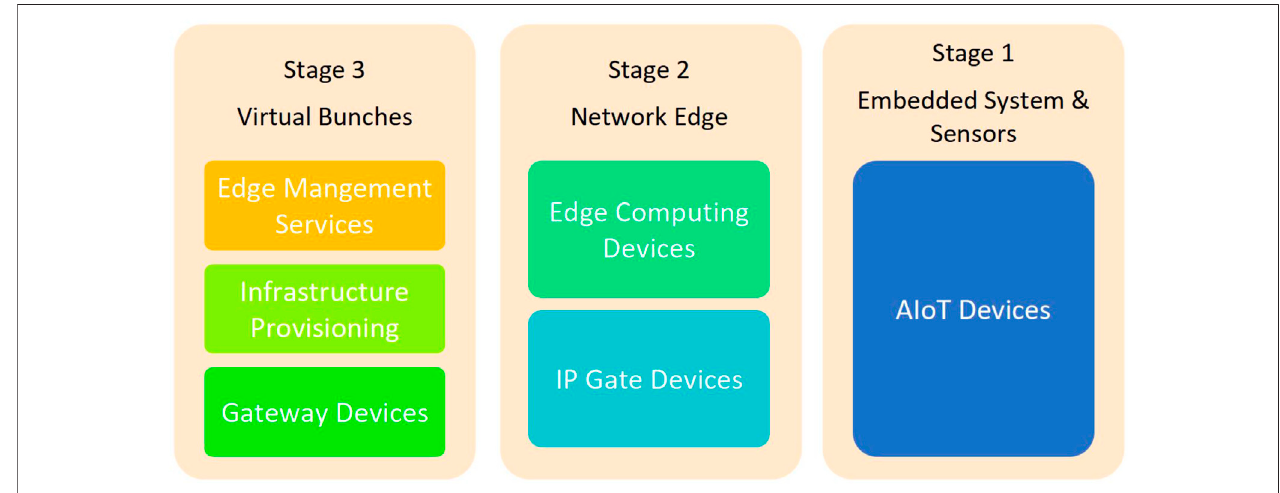
FIGURE 2 | Layered architecture for reliable edge-computing technology and smart AIoT construction.